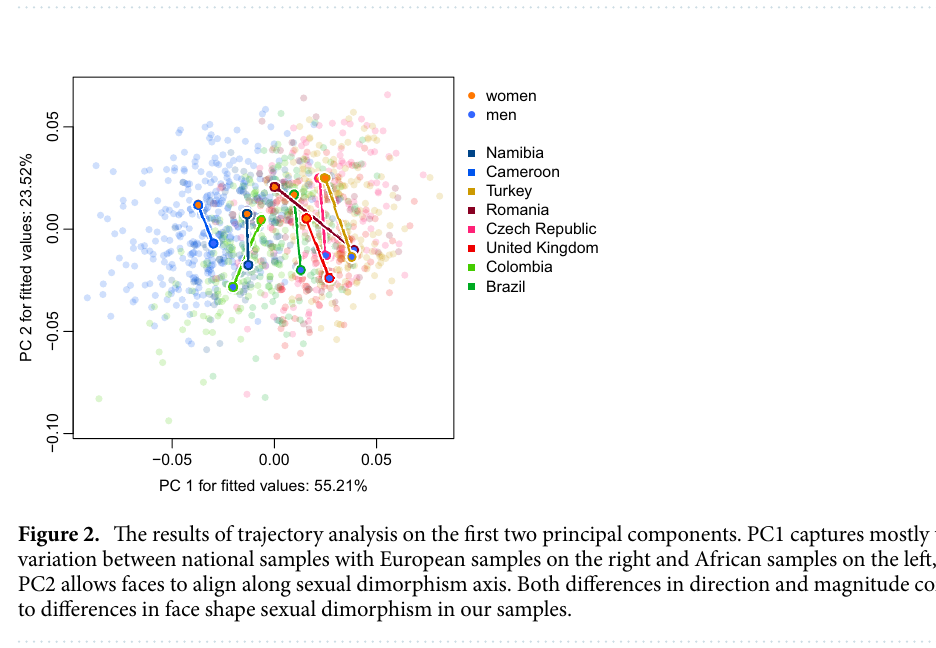
The trajectory analysis (see Fig. 2) revealed that PC1 mostly captures the variation between population sam- ples with European samples on the right and African samples on the left, while PC2 allows faces to align along